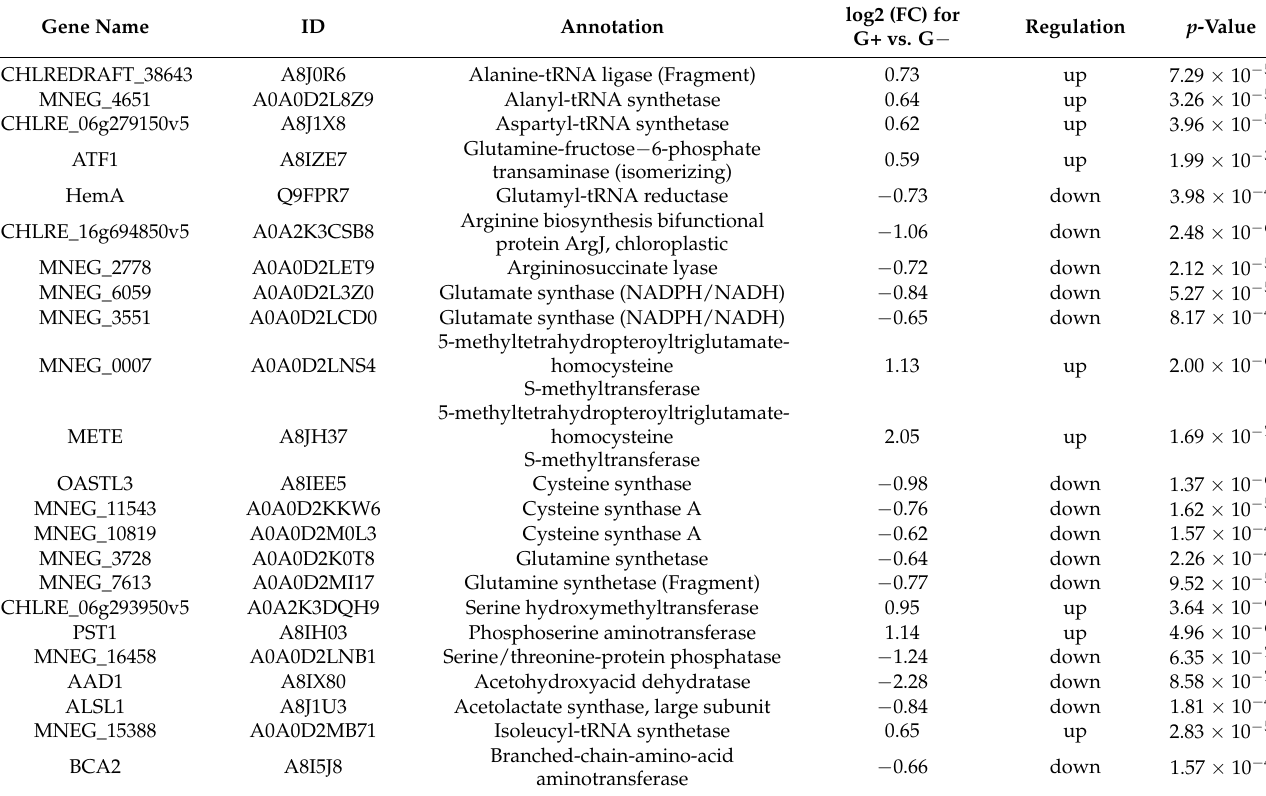
Table 2. Differentially expressed proteins associated with amino acid metabolism of Chromochloris zofingiensis with or without glucose.